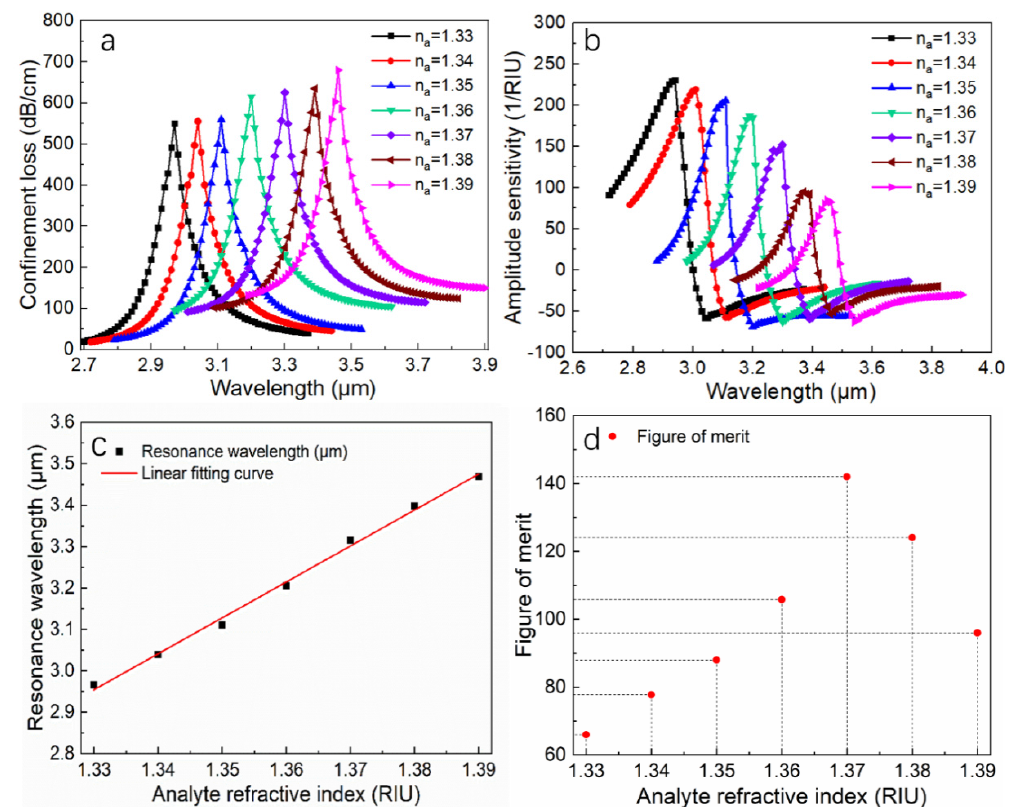
Figure 5. ( a ) Loss spectra for di ff erent analyte RI n a between 1.33 and 1.39; ( b ) amplitude sensitivity (AS) with di ff erent analyte RIs when d 1 = 2.8 µ m, d 2 = d 3 = 7.0 µ m, Λ 1 = 6.0 µ m, Λ 2 = 6.2 µ m, and T Au = 40 nm; ( c ) linear correlation degree for resonance wavelength versus di ff erent analyte RIs; ( d ) figure of merit (FOM) of this sensor versus di ff erent analyte